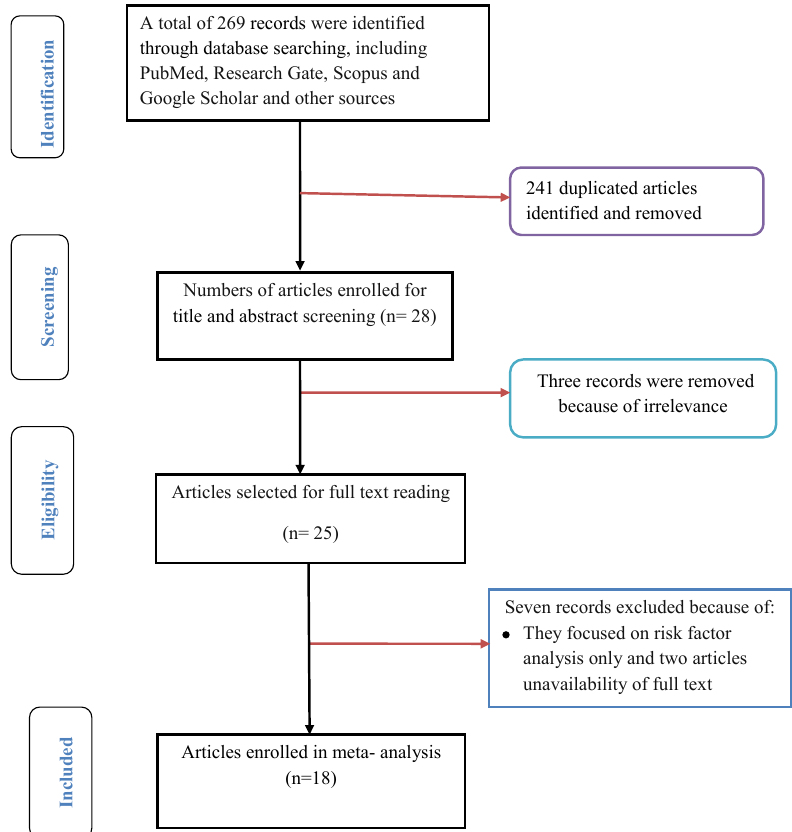
Figure 1: Flow chart depicting the selection process of included